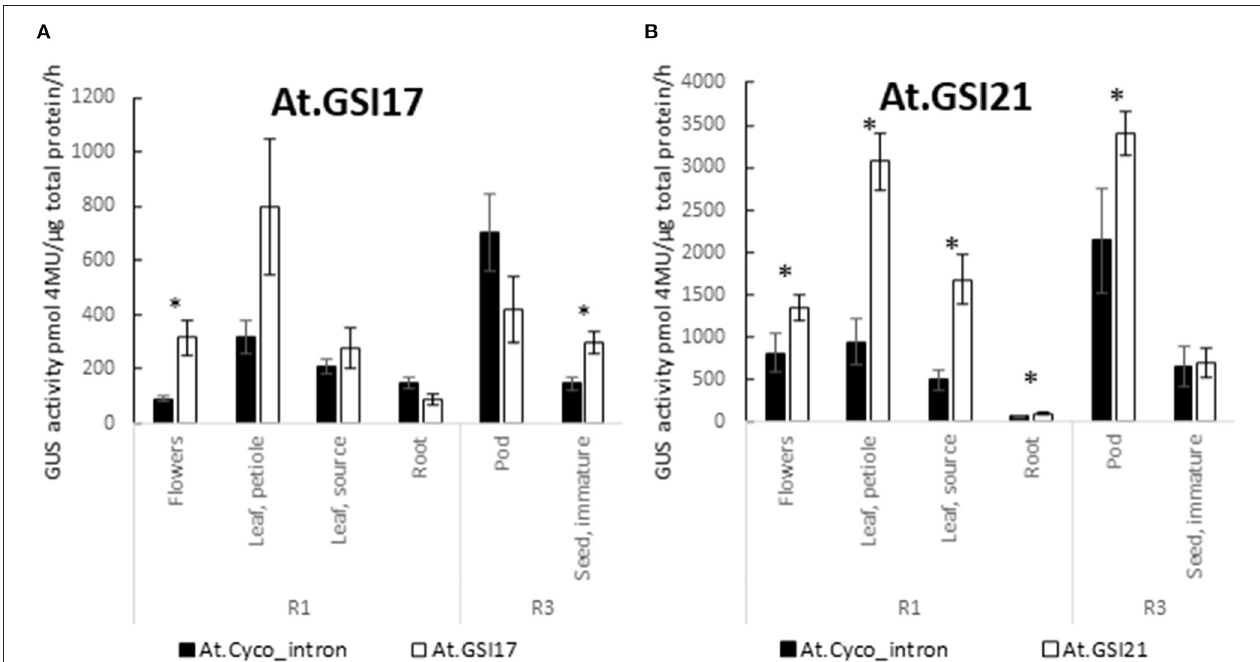
FIGURE 5 | GSIs enable effective expression. Introns At.GSI17 (A) and At.GSI21 (B) were tested in the context of At.GSP576 and At.GSP571, respectively, and the expression from cassettes with GSIs was compared with At.Cyco_intron when paired with the same promoter. GUS reporter gene activity was performed on leaf, root, flowers, pods, and seeds from transgenic soybean plants at R1 and R3 stages. GUS enzyme activity on MUG substrate was normalized to total protein and reported as pmol 4-MU/ µ g total protein/h. At least six independent transgenic events were analyzed, and the data are reported as the mean with standard error. *Indicates a statistically significant difference between At.Cyco_intron and the GSI when compared in the same tissue-type with p -value threshold corrections to control for false discovery < 0.05 in multiple